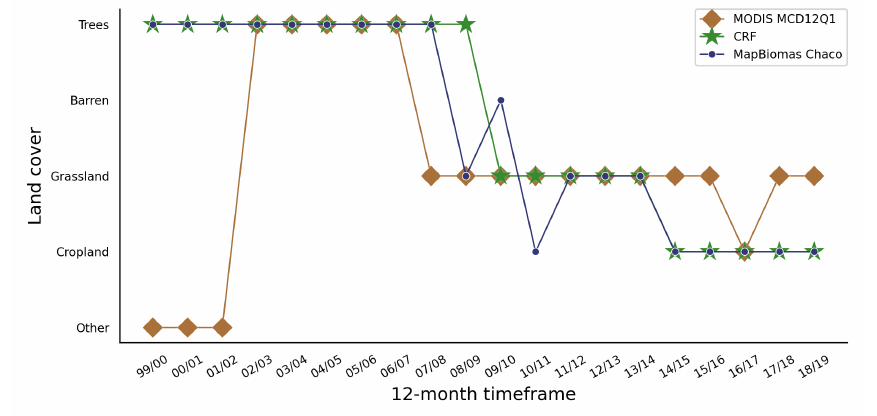
Figure A5. Example of land cover change for three land cover products: this study’s CRF method; MODIS MCD12Q1 product; and MapBiomas Chaco. The coordinate plotted is − 21.867 ◦ S, − 60.72 ◦ W, which is also illustrated by the center white circle in Figure